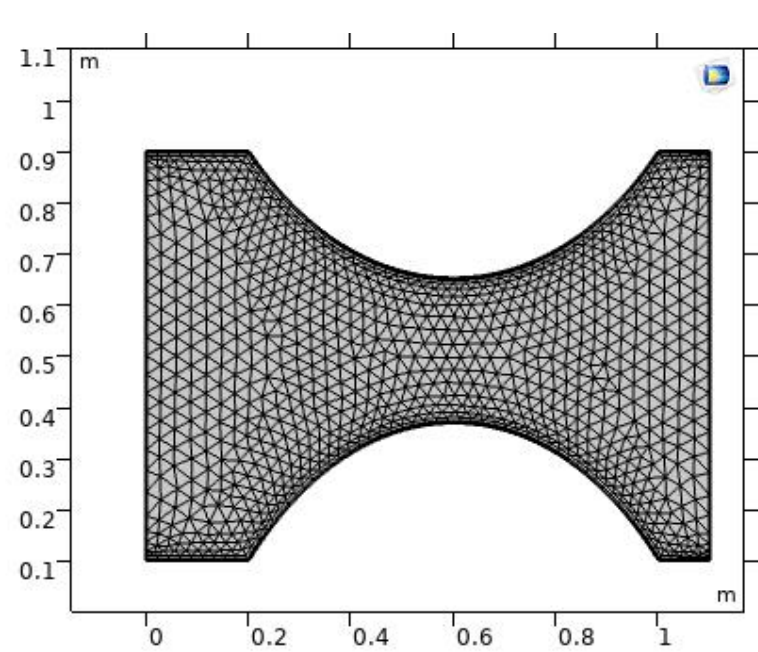
Appl. Sci. 2022 , 12 , x FOR PEER REVIEW Figure 6. Normal element size mesh. Figure 6. Normal element size mesh.